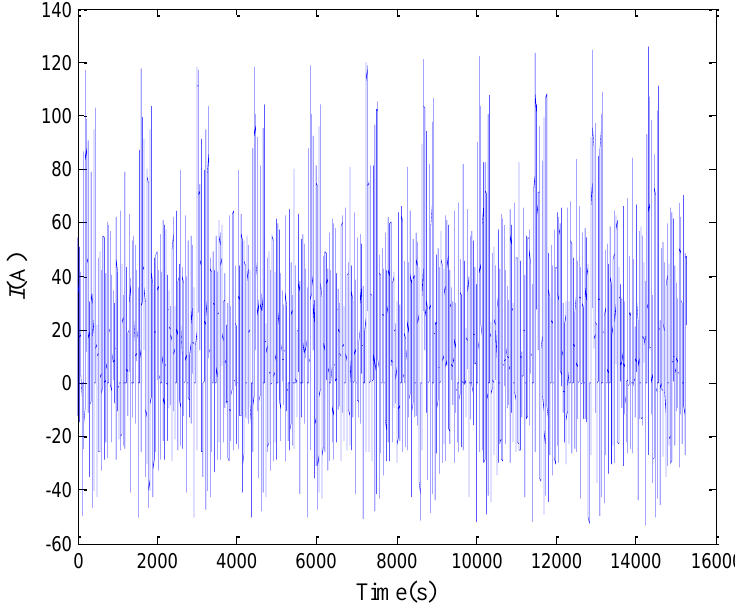
Figure 15 . Battery current measurement during FUDS